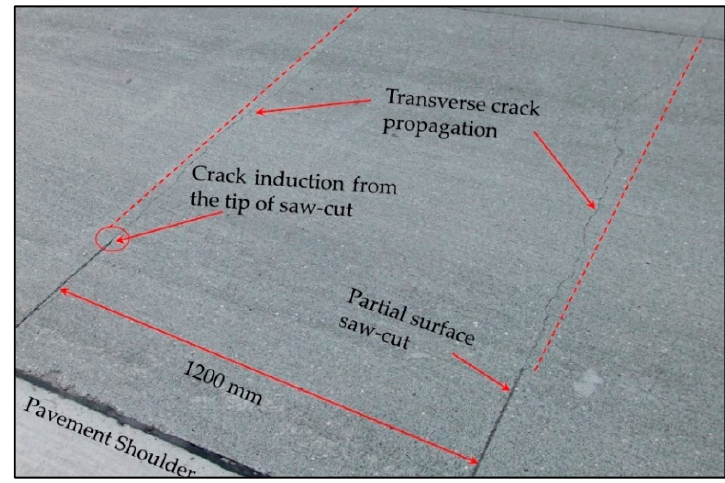
Figure 5. Active crack development on the Motorway E313 section.